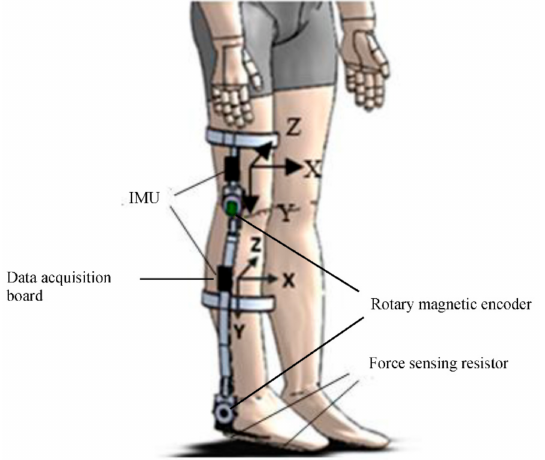
Figure 2. The placement of sensors and data acquisition board [17].